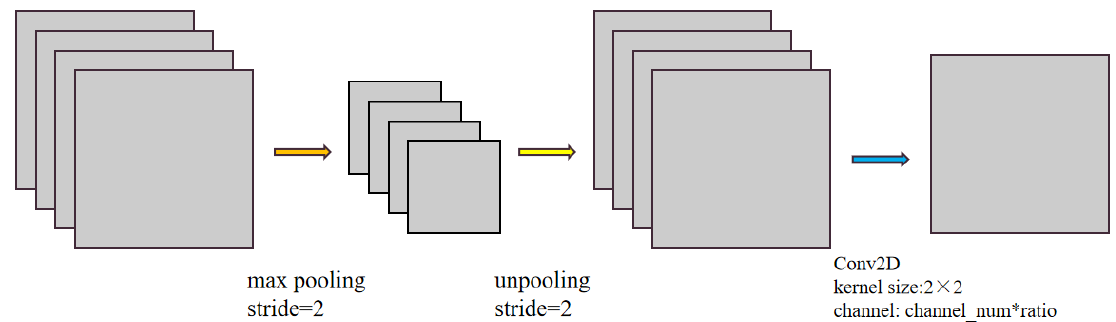
Figure 11. Residual compression module.